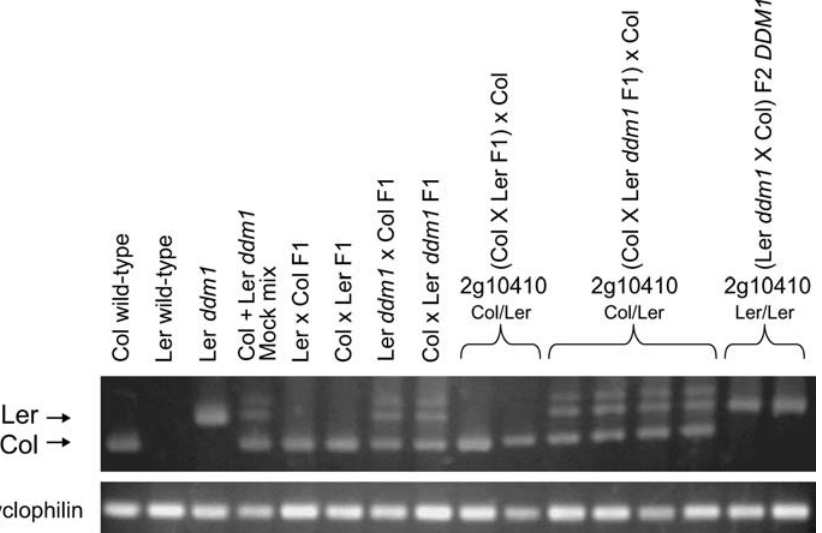
Figure 4. RT-PCR/CAPS (Cleaved Amplified Polymorphic Sequence) Detection of Allele-Specific Expression at At2g10410 The Col allele is cleaved with Bst B1, generating a 480-bp fragment plus an undetected 70-bp fragment, while the Ler allele is uncleaved (550 bp). At2g10410 is not expressed in Ler wild-type, but is expressed in wild-type Col and Ler ddm1 mutant, as shown in Figure 1. A mixture of cDNA templates from Col and Ler ddm1 samples was used to illustrate the detection of bi-allelic expression; note an additional higher molecular weight heteroduplex band (see Materials and Methods) in samples showing bi-allelic expression. A total of five Col 3 Ler heterozygous At2g10410 BC1 and ten Col 3 Ler